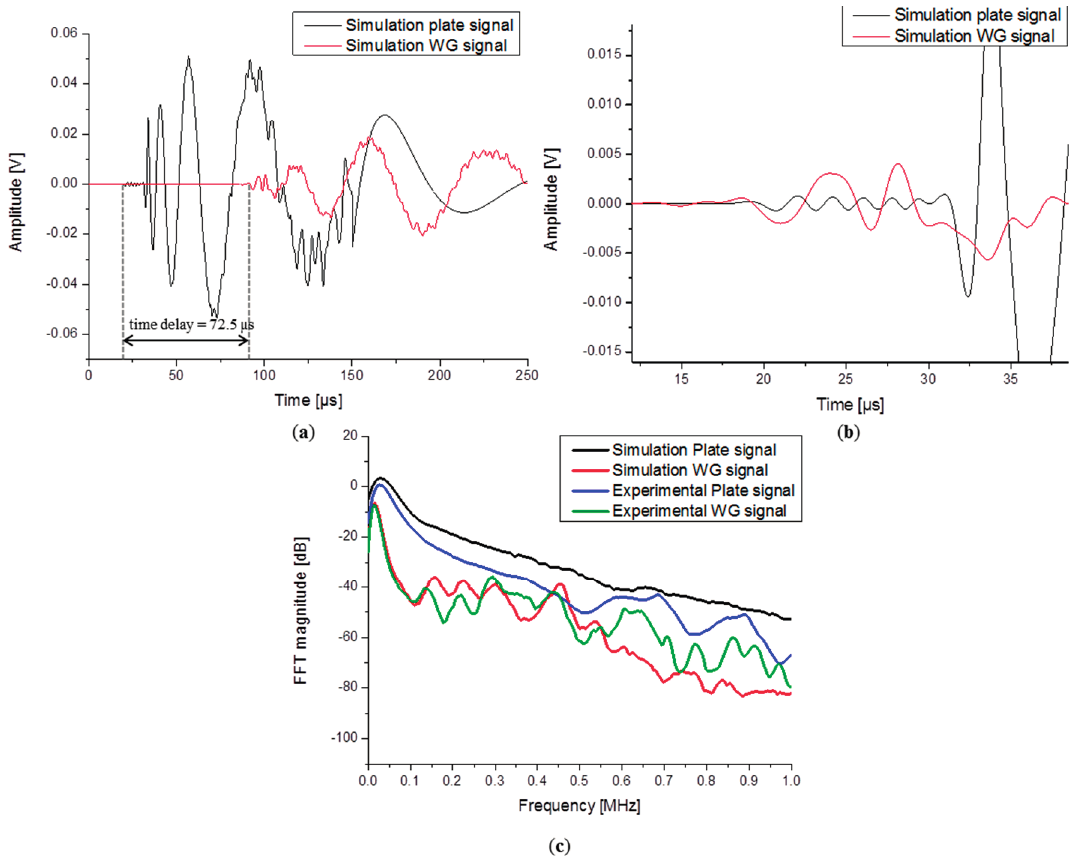
Figure 8. Comparison between ( a ) simulated signals and ( b ) simulation signals with a detail view of the S 0 mode and ( c ) FFTs of simulated and experimental